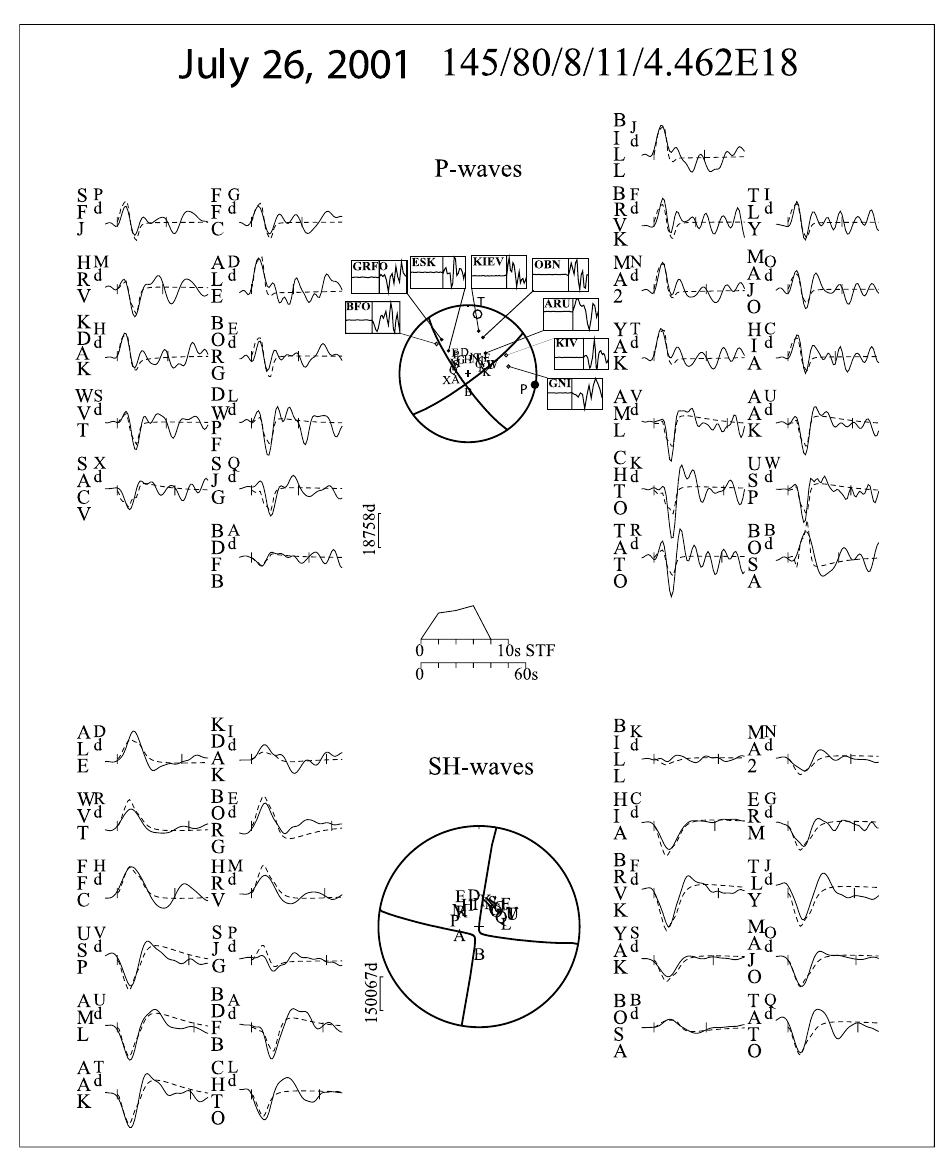
Fig. 2. Teleseismic waveform modelling results: comparison between observed (solid line) and synthetic (dashed . line) P and SH long-period waveforms. The estimated strike, dip and rake (in degrees), the depth (in km) and the seismic moment (in N (cid:117) m) are shown at the top of the figure. Stations are ordered clockwise by azimuth and the station code of each waveform is accompanied by a letter corresponding to its position within the focal sphere. Vertical bars show the inversion window. The employed source time function and the waveform time scale are depicted at the centre of the figure. Waveform amplitude scales (in microns) are shown to the left of the focal sphere. The insets show the first motion polarities at stations with epicentral distances lower than 30 ° , not included in the inversion, but complimentary used to constrain the nodal